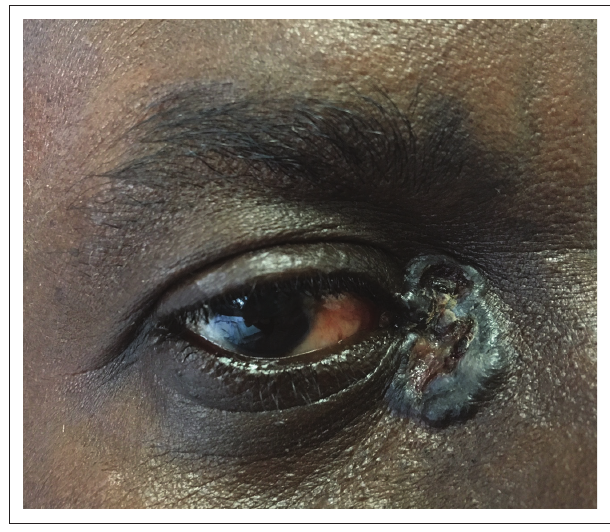
FIG URE 3: Pigmented basal cell carcinoma involving the medial